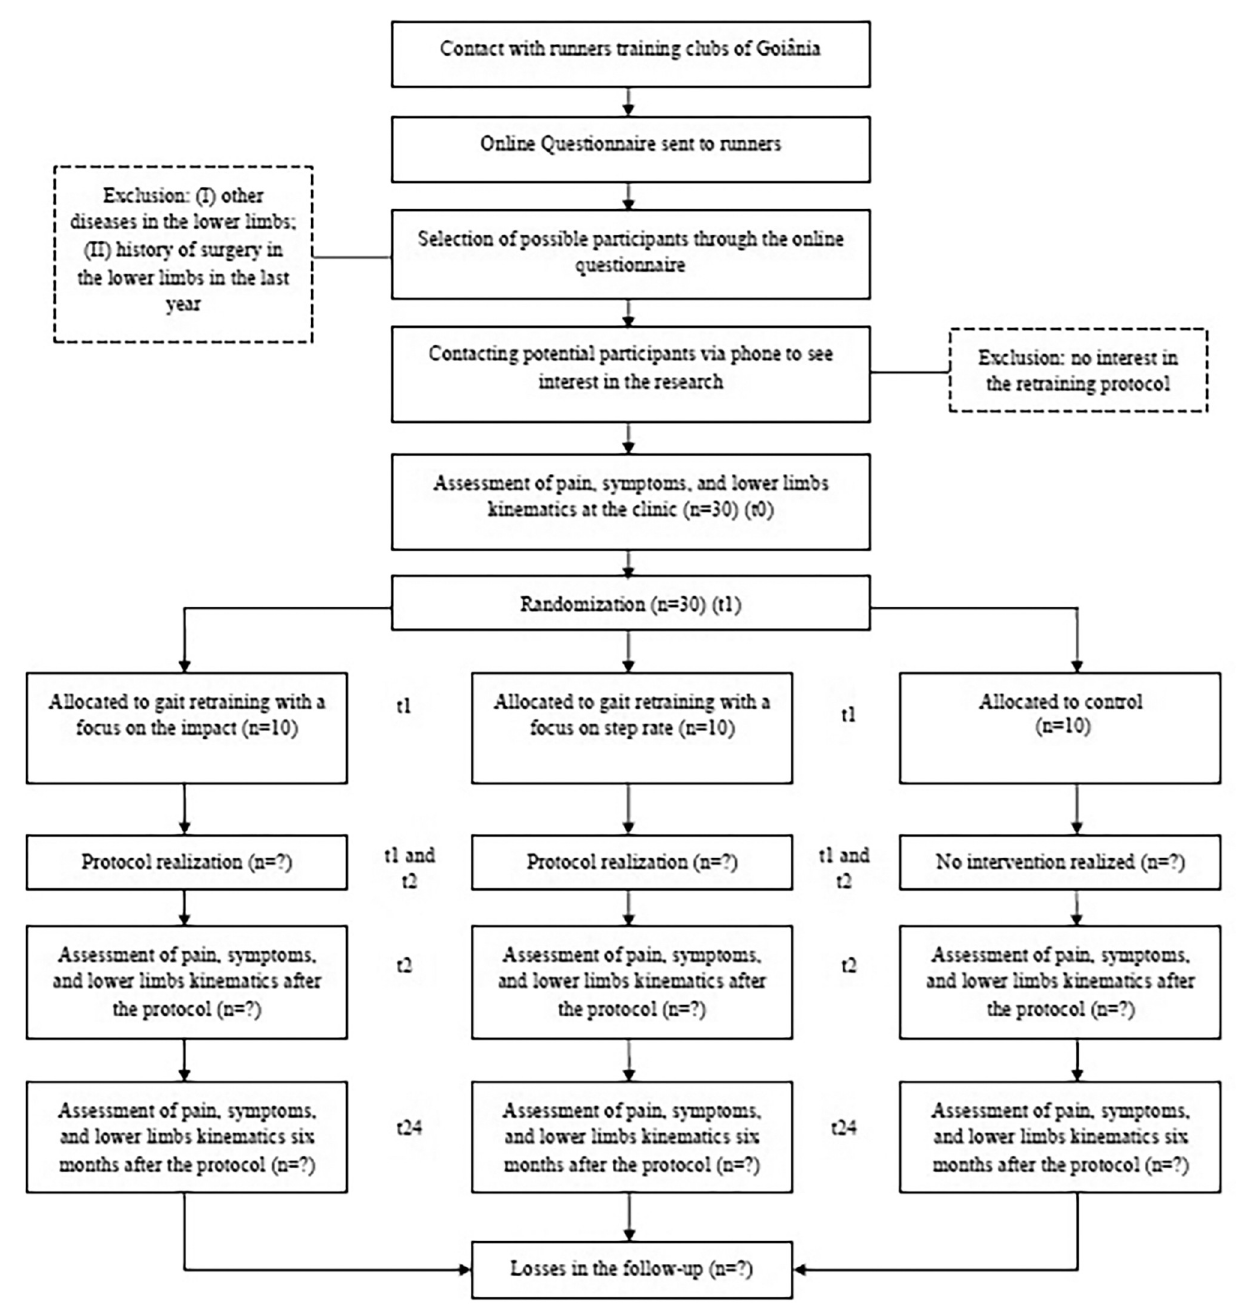
Fig 1. Diagram of the